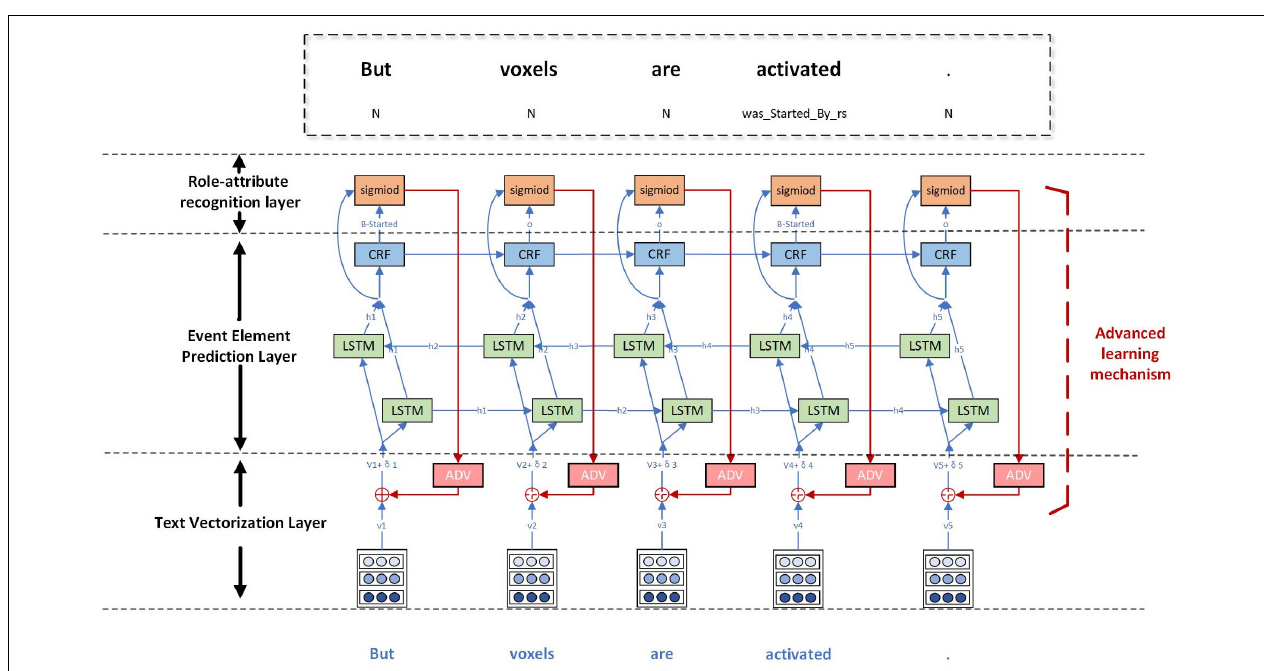
FIGURE 6 | The AT-NeuroEAE model. The text vectorization layer encodes sentences as textual vectors based on lexical units, case features, and domain terminology dictionaries. The event element prediction layer predicts the potential event elements by using the BiLSTM-CRF model. The role-attribute recognition layer identifies the role and attribute of argument by using the sigmoid function. The adversarial learning mechanism adds small and persistent disturbances to the input of joint model for improving the robustness and generalization of the model. BiLSTM: bi-directional long short-term memory; CRF: conditional random fields; adv: adversarial